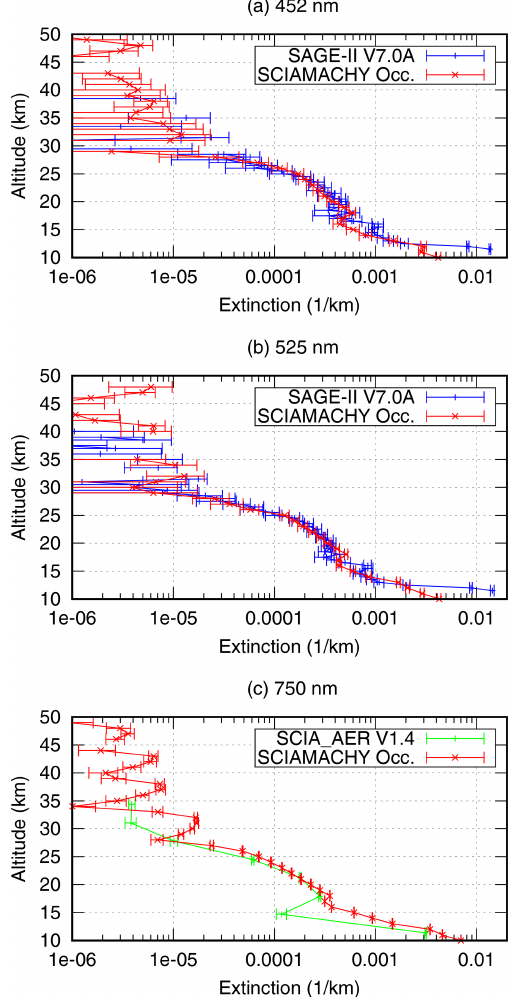
Figure 8. Retrieved aerosol extinction profiles from SCIAMACHY solar occultation (red), SAGE-II product v7.00A (blue) and SCIA- MACHY limb aerosol extinction product v1.4 (green) for orbit 8014 (11 September 2003) and different wavelengths (a–c)